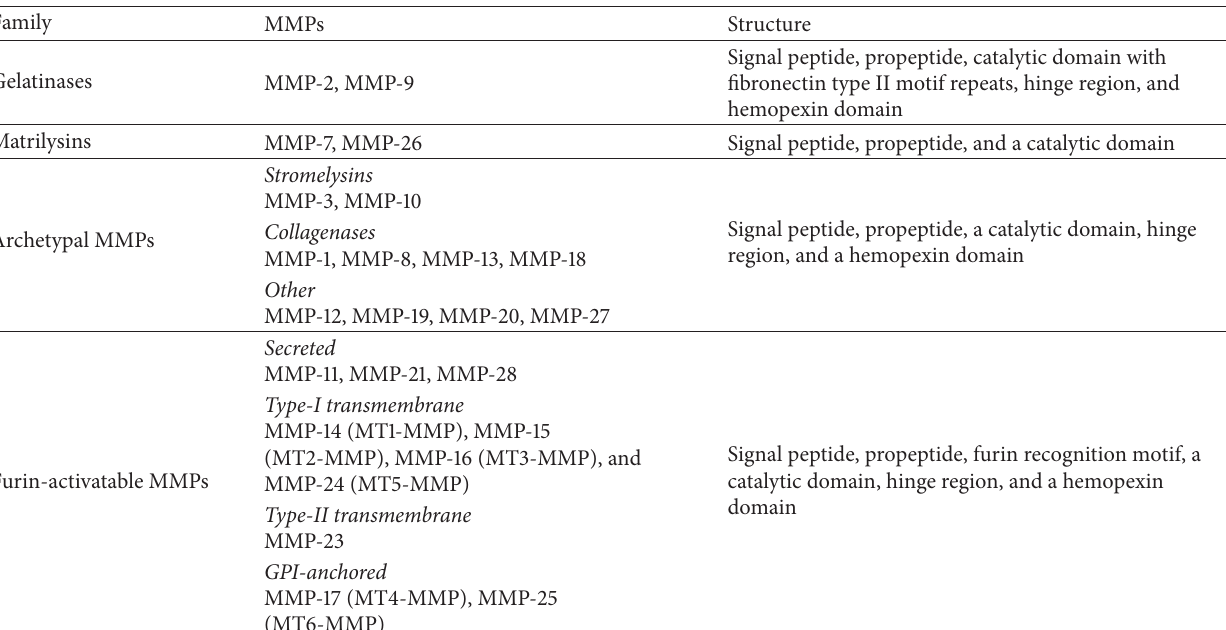
Table 1: Classification and structure of